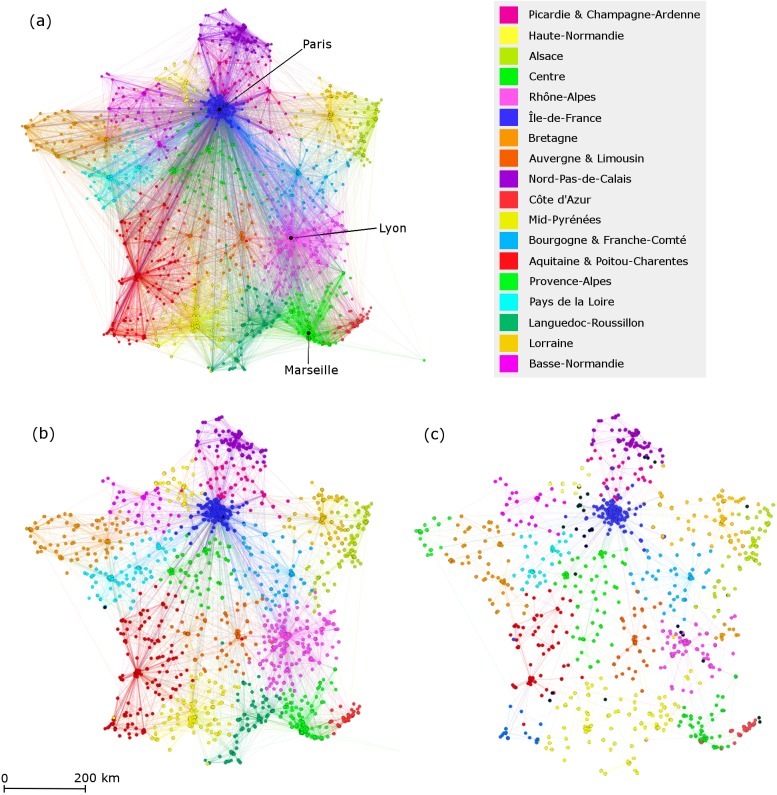
Regional clustering of communities detected with greedy algorithm.Network hospitals and patient trajectories of the healthcare network in France of (a) the general healthcare network, (b) the suspected-HAI healthcare network, and (c) the HAI-specific healthcare network. In the general healthcare network, 18 communities were detected by the community clustering algorithm. Four of the 18 communities identified by the algorithm combine hospitals from two regions each, such that the 22 geographical regions are mapped into 18 communities. The original 22 French metropolitan regions before they were reformed to 13 regions implemented in 2016 are shown to correspond to the 2014 data. For the HAI-specific and suspected-HAI networks, the algorithm detected a higher number of communities (36 and 21 communities respectively). The communities, which overlapped the same regional communities in the general network, were given the same color and the newly detected communities were given different colors.